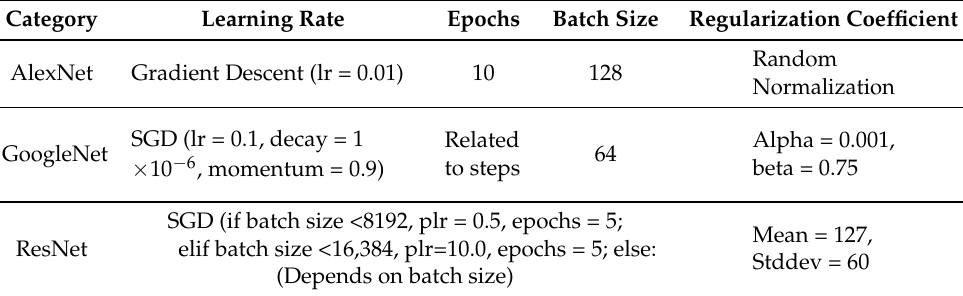
Table 1. Examples of hyperparameters for machine